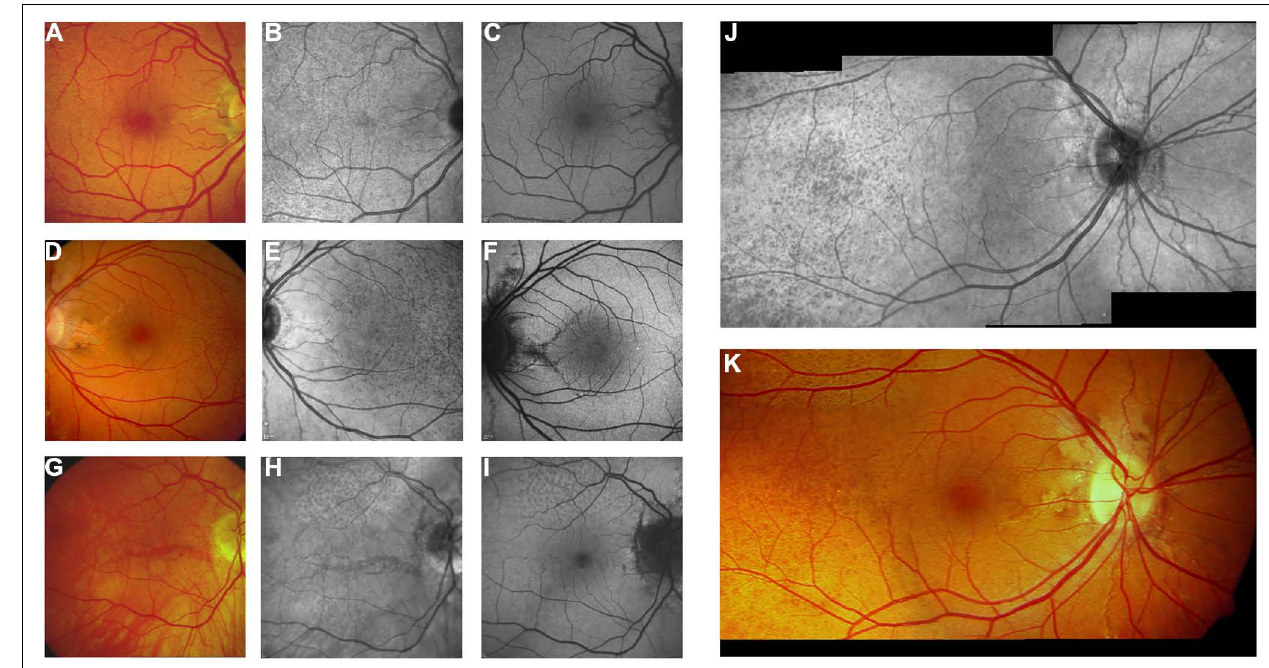
FIGURE 6 | Near-infrared reflectance imaging and 488 nm fundus autofluorescence in pseudoxanthoma elasticum. Angioid streaks and peau d’orange are best and most reliably visible on NIR reflectance imaging (B,E,J) correlating well with findings on funduscopy (A,D,K) . Peau d’orange is usually not discernible on 488 nm fundus autofluorescence images (C,F) .